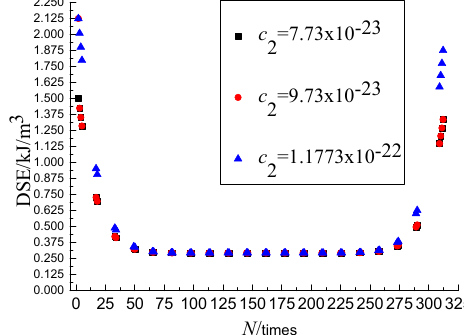
Figure 7. Sensitivity analysis of parameter c 2.